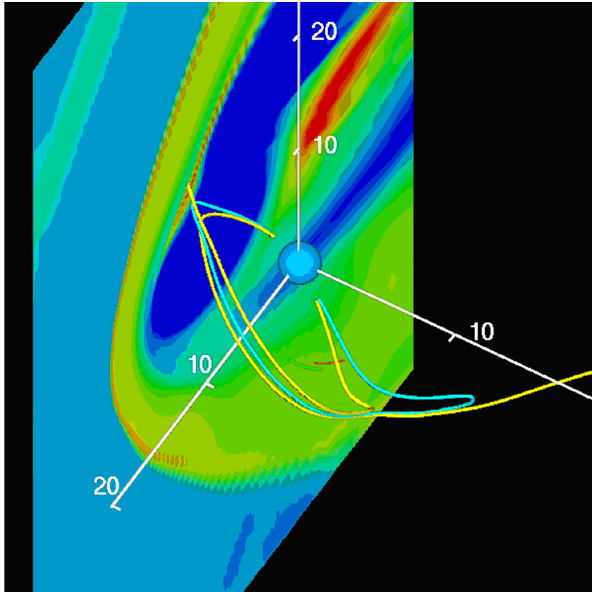
Fig. 11. Results from the MHD model showing a few magnetic field lines (yellow: open; blue: closed) and an arbitrary colour code for the plasma beta (shown in a x,z plane).